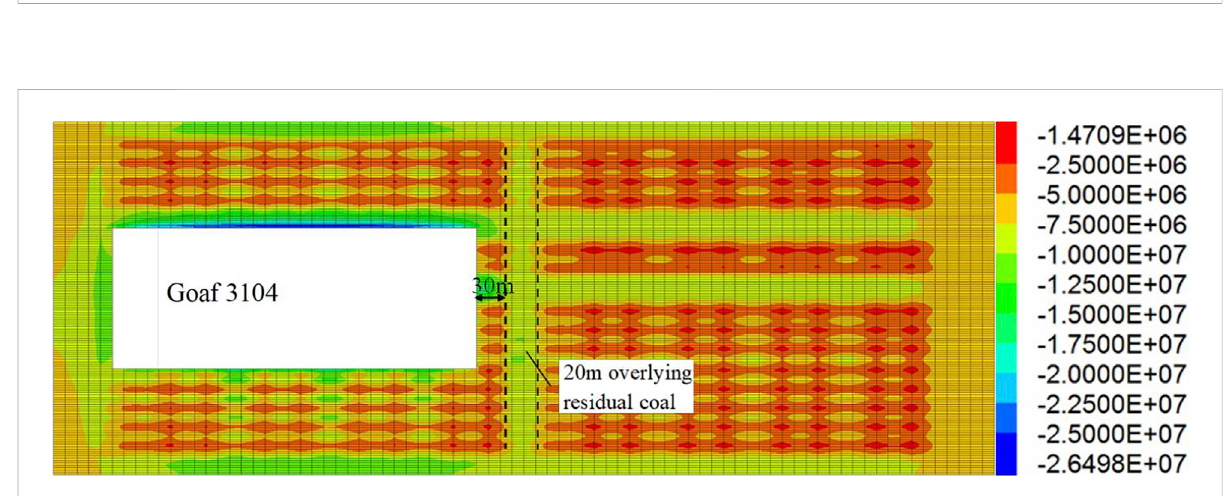
FIGURE 22 Cloud diagram of vertical stress distribution at 30m of overlying residual coal pillar (Pa).